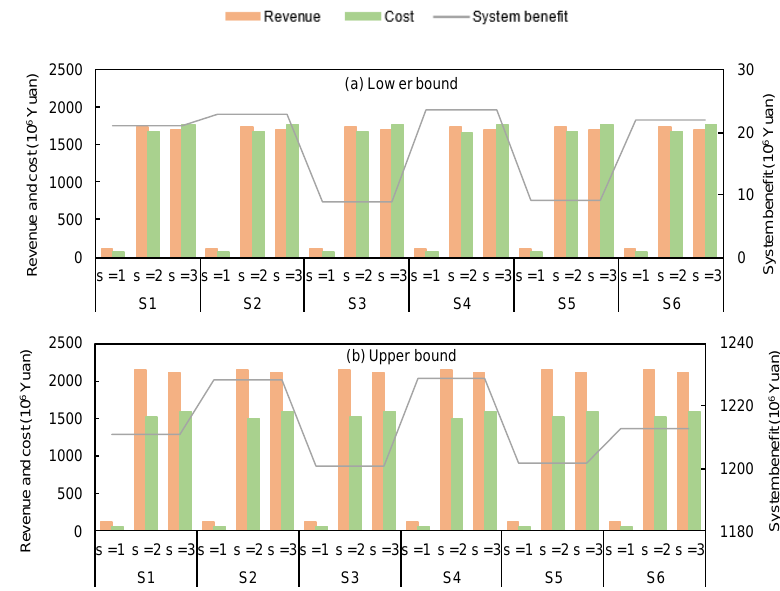
Figure 3. Revenues, costs, and benefits: ( a ) Lower bound, ( b ) Upper bound.